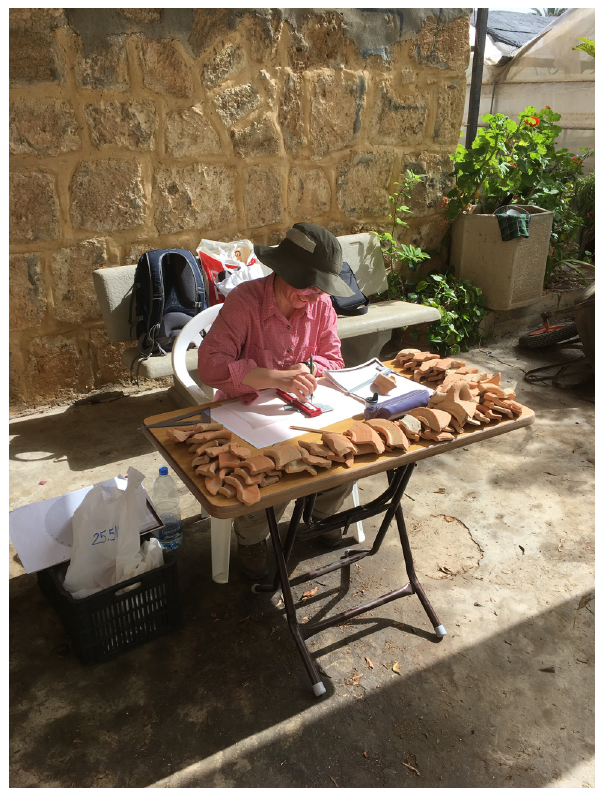
Figure 2: Andrea Kilian at work drawing ( surrounded by amphora sherds )